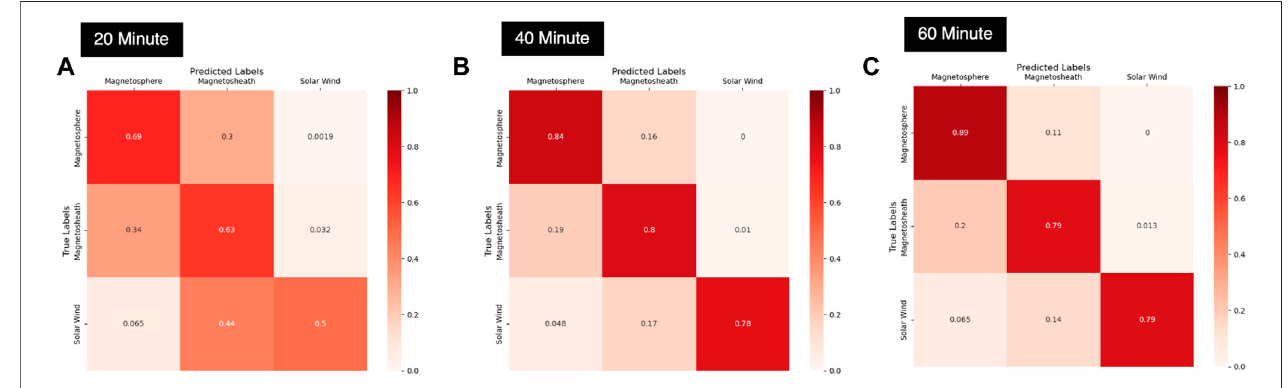
FIGURE6| Comparison oflengthofthetimesampleused withoverallprediction performanceon samplescontainingaboundarytransitionforthe 20-min (A) ,40- min (B) and 60-min (C) RNN models. The comparisons here are shown as normalized confusion matrices.